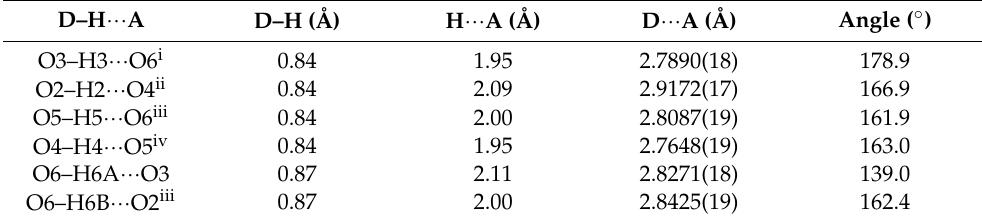
Figure 3. Water molecule and CG molecule interlinked by hydrogen bonds in the CG-H 2 O crystal structure. There were two types of ring motifs, i.e., R (cid:2872)(cid:2872) (15), R (cid:2870)(cid:2872) (7) along b axis. Hydrogen bonds were represented by dashed lines. For clarity, hydrogen atoms not involving in hydrogen bonds were omitted. Table 2. Intermolecular hydrogen bond geometry for CG-H 2 O. Table 2. Intermolecular hydrogen bond geometry for CG-H 2 O.